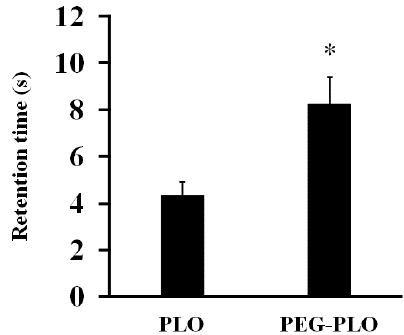
Figure 4. Retention time of PEG-PLO solutions in the in vitro inclined plate test. Retention time was defined as the time required for the solution to flow 3 cm. All measurements were performed at r.t. on the same day. Each data column represents the mean ± S.E. ( n = 6), * p < 0.05 compared with the PLO.